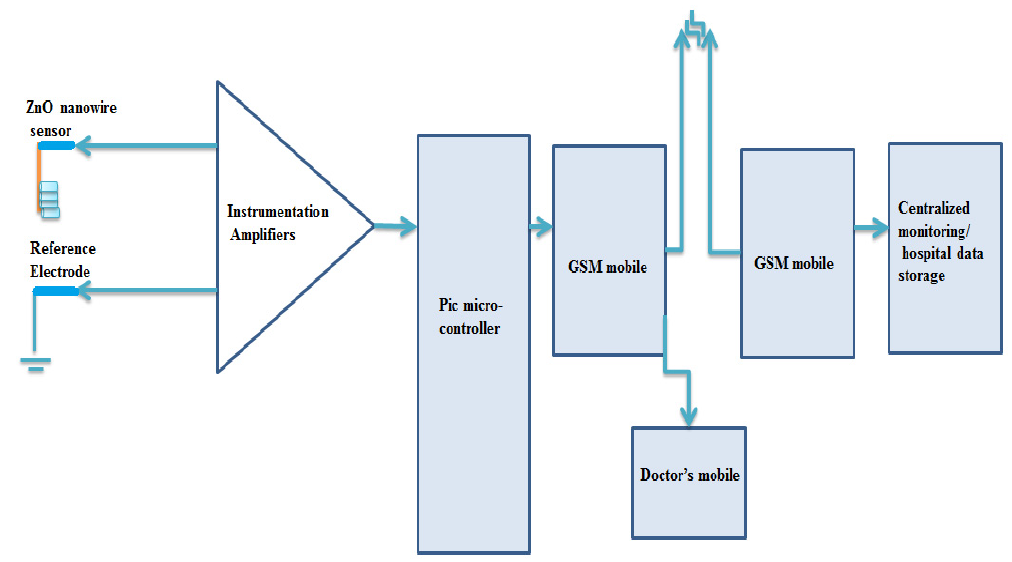
Figure 5. The proposed system block diagram of wireless remote monitoring system for the functionalized ZnO nanowire arrays based glucose